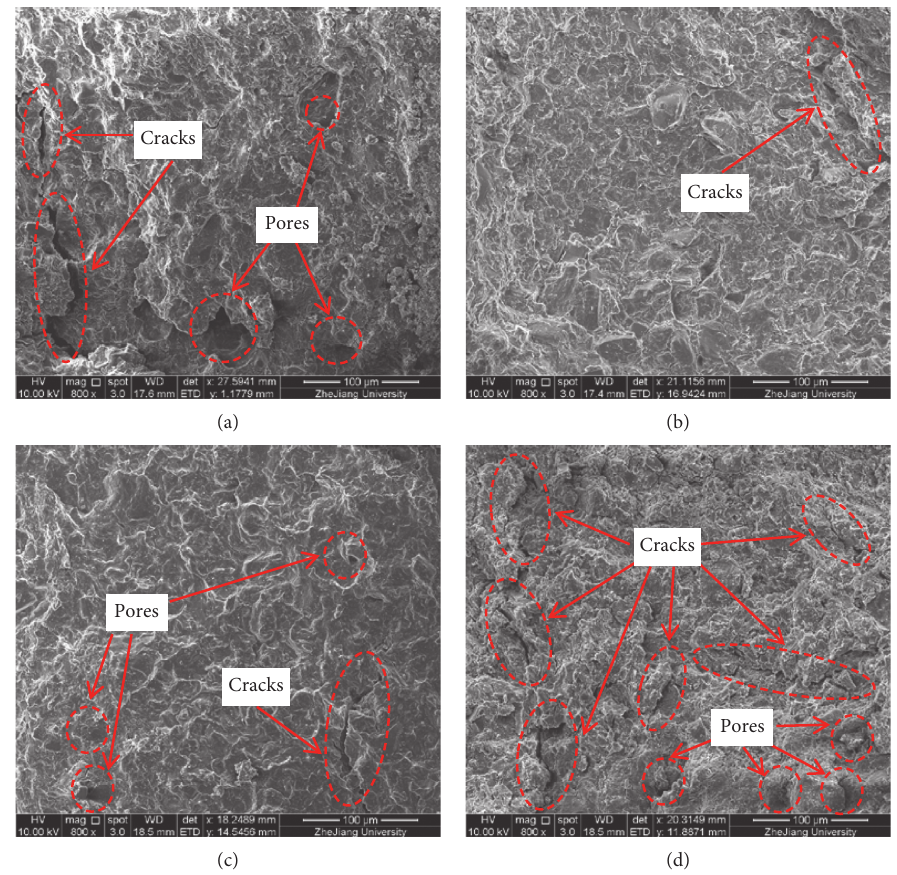
Figure 7: SEM images of at 28d with different MK contents. (a) MK0, (b) MK2, (c) MK4, and (d)